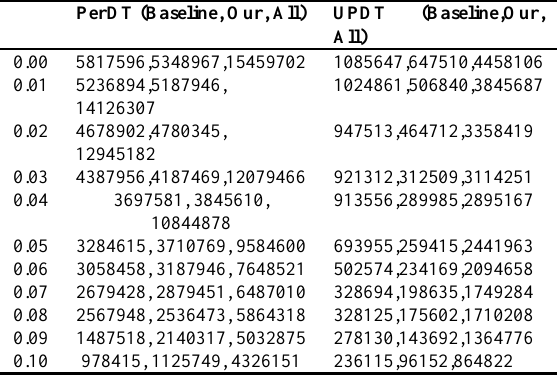
Table 8. Effect of feature removing on feature Space Dimension. UPDT (Baseline,Our, PerDT (Baseline, Our, All)